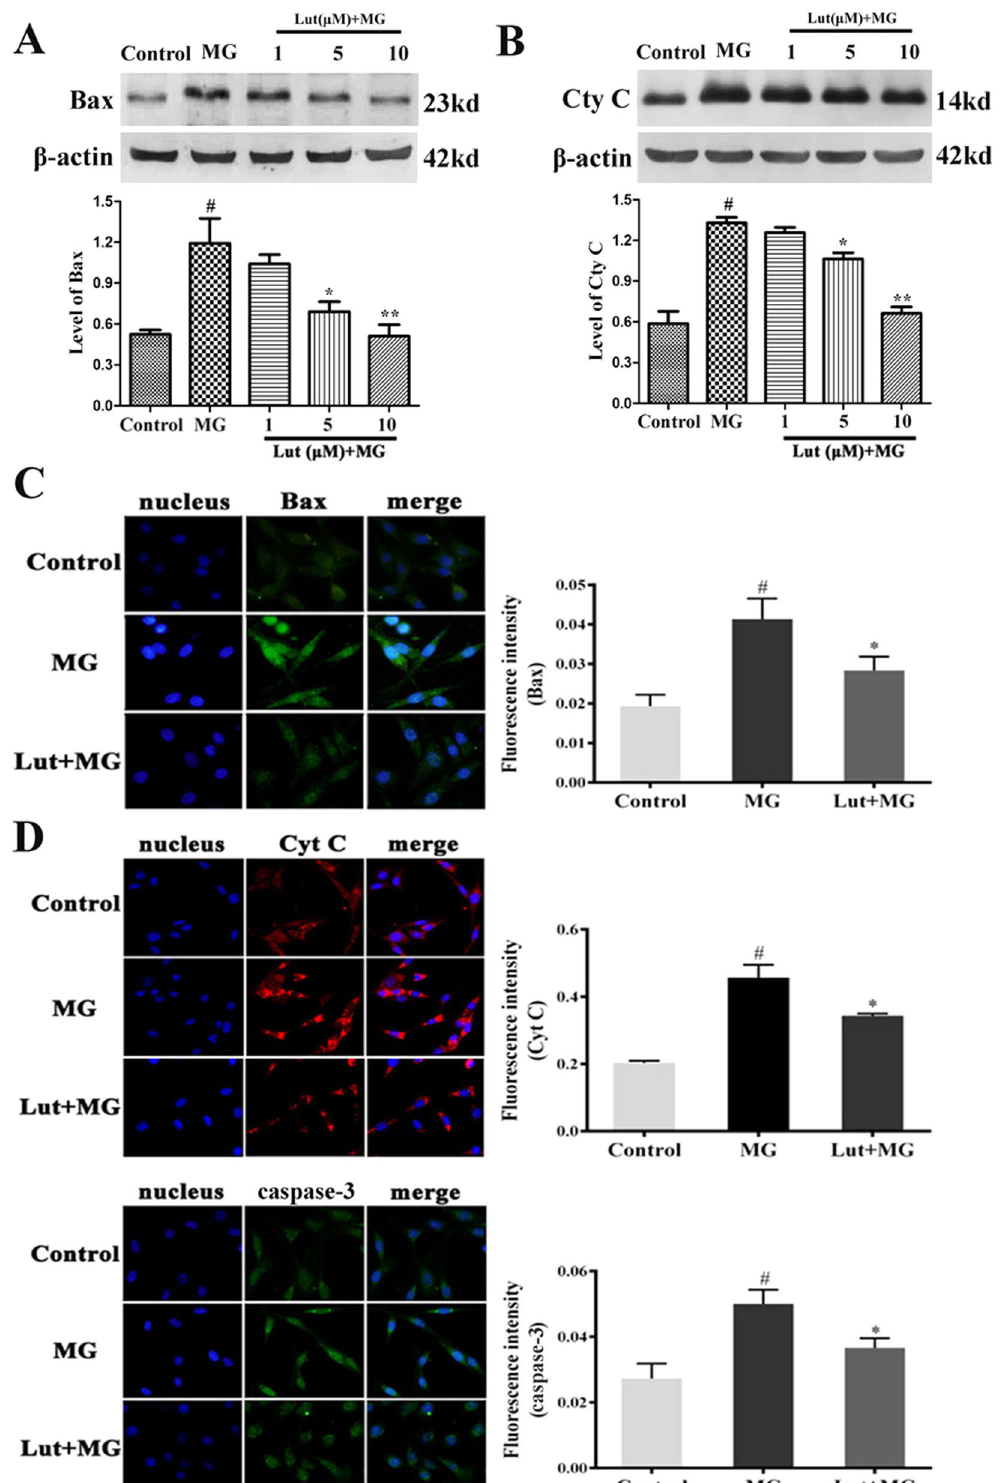
Figure 4. Luteolin (Lut) inhibited MG-induced overexpression of Bax, Cyt C and caspase-3. The cells were pretreated with Lut (1, 5, 10 μ M) for 3 h, followed by 0.5 mM MG administration for an additional 36 h. Bax ( A ) and Cyt C ( B ) were determined by western blotting analysis and the band densities were normalized with β -actin. Data are presented as means ± SD of three independent experiments, each performed in triplicate. # p < 0.01 vs control group; * p < 0.05 and ** p < 0.01 vs MG group. The expression of Bax ( C ), Cyt C ( D ) and caspase-3 ( E ) was analyzed by immunofluorescent staining. Histograms show the quantification of the fluorescence intensity of the corresponding proteins. # p < 0.01 vs control group; * p < 0.05 vs MG group. The full- length blots/gels are presented in Supplementary Figs S6 and